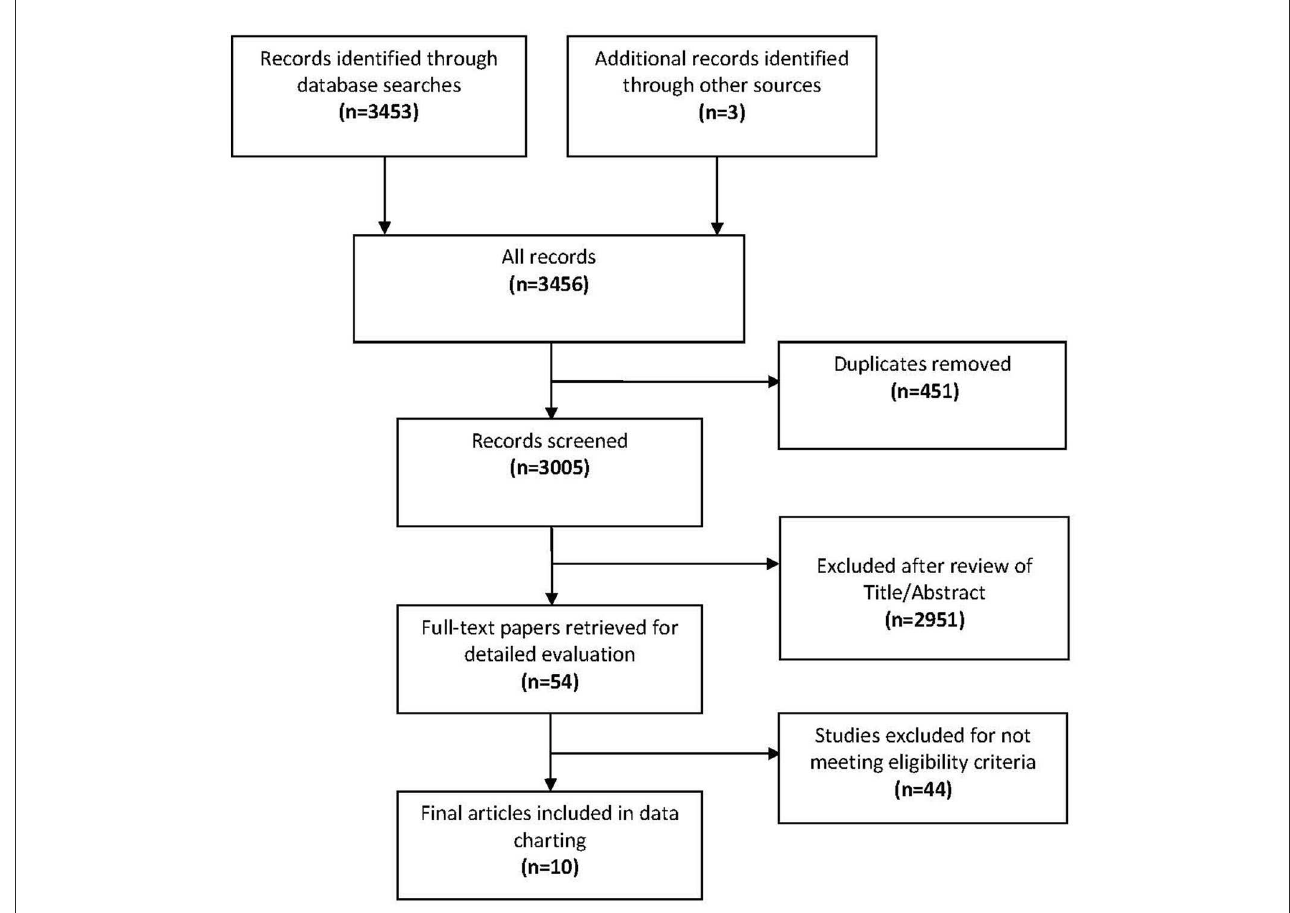
FIGURE1 Flow diagram of the study selection process and